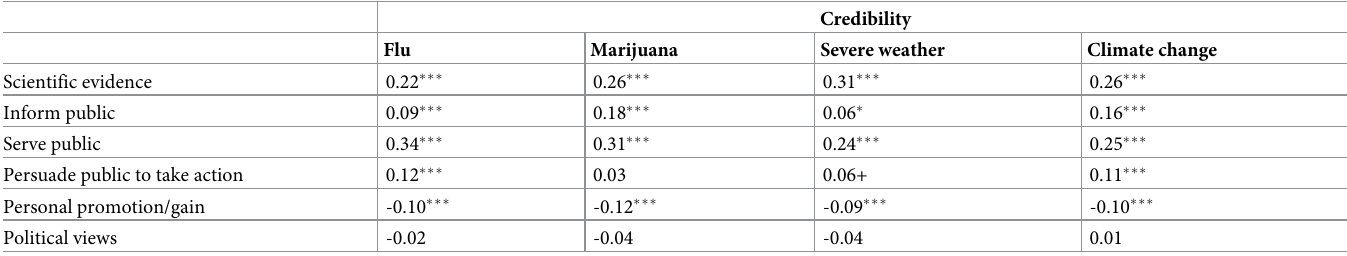
Table 4. Perceived motivations relationships with credibility.